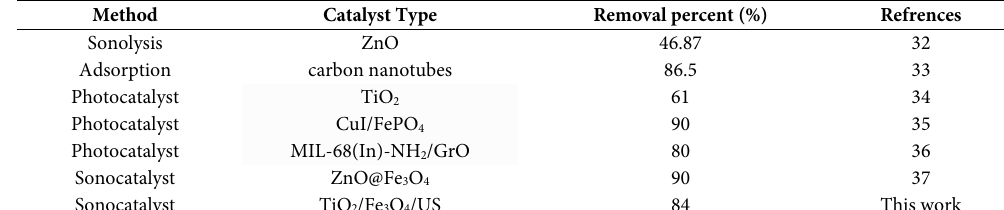
Table 1. Comparison of research results with other studies